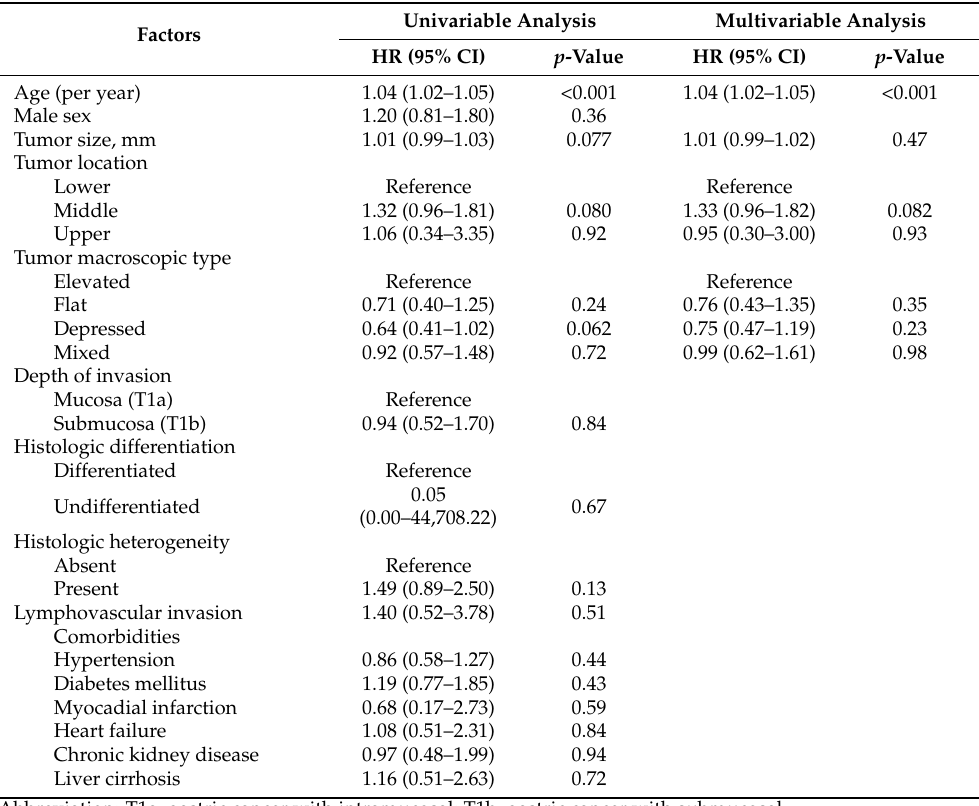
Table 2. Factors associated with metachronous gastric cancer.